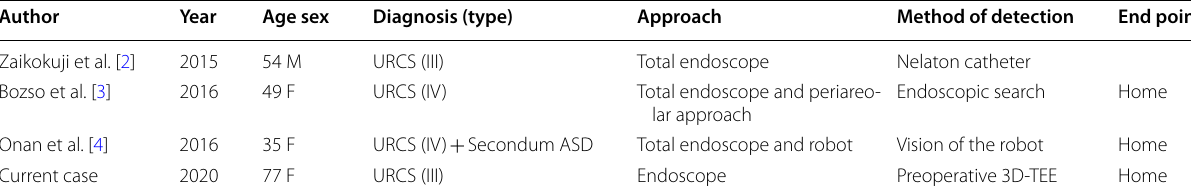
URCS unroofed coronary sinus, ASD atrial septal defect, 3 D three-dimensional, TEE transesophageal